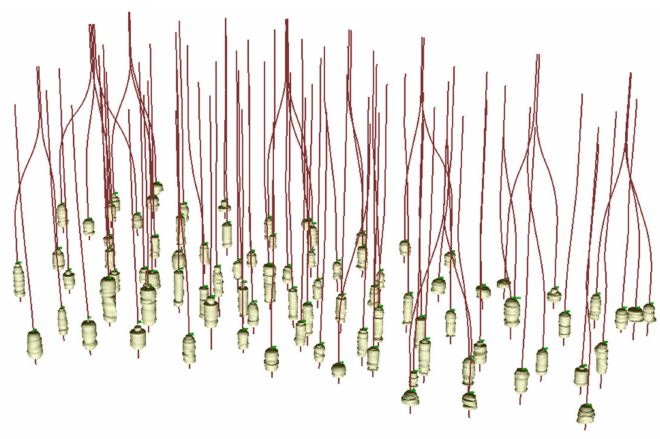
Figure 4. Example of a drawing of the caverns belonging to the EPE deposit. Using the presented algorithm, based on the data provided by the cavern operator SGW (Salzgewinnungsgesellschaft Westfalen mbH & Co. KG, Ahaus, Germany) the au- thors made forecast calculations of the future land surface deformation for the period to 12.30.2019.